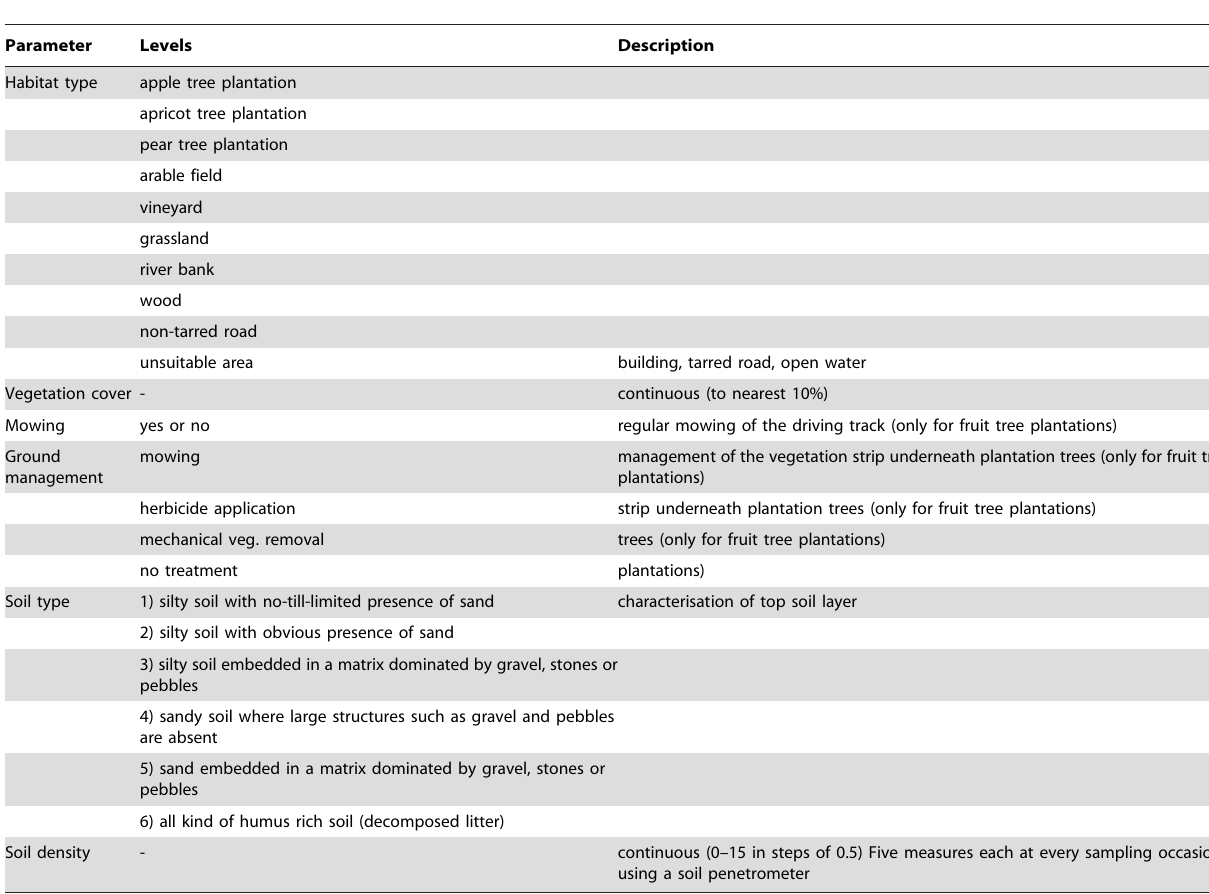
Table 1. Description of habitat variables recorded at mapping locations for modeling hoopoe territory occupancy and mole cricket